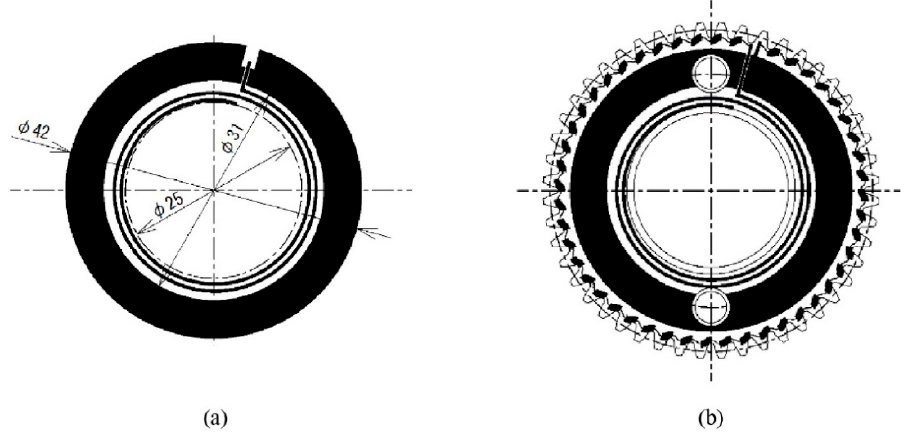
Figure 2. The laser sintering patterns: ( a ) monitoring antenna; ( b ) sensor